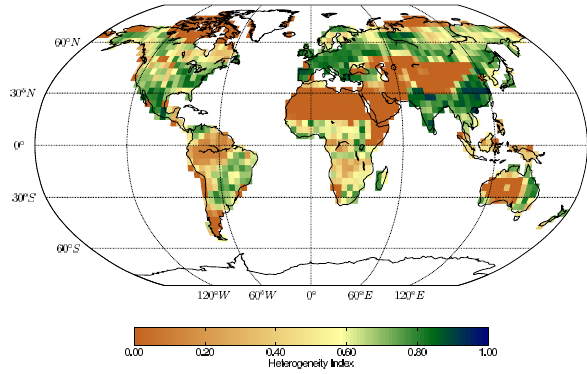
Fig. 6. Heterogeneity index for 1861 land cover based on the HYDE v 3.1 crop data set. This index is defined in Sect. 4.